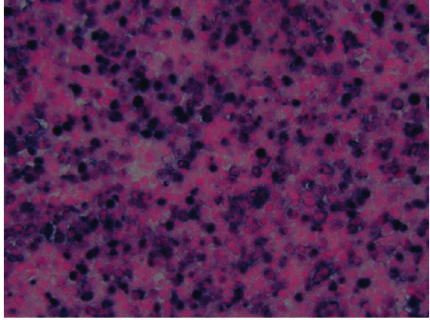
Figure 4: In situ hybridization was diffusely positive for Eps- tein–Barr virus (EBV) RNA.